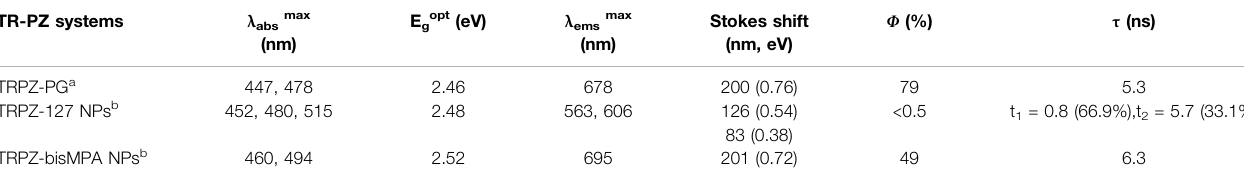
TABLE 1 | Optical properties of the TR-PZ systems dye in THF a and NPs in water b . TR-PZ